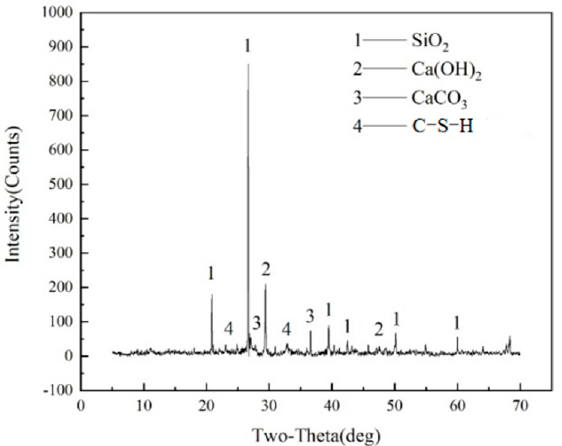
Figure 5. An XRD analysis of activated recycled brick mortar.